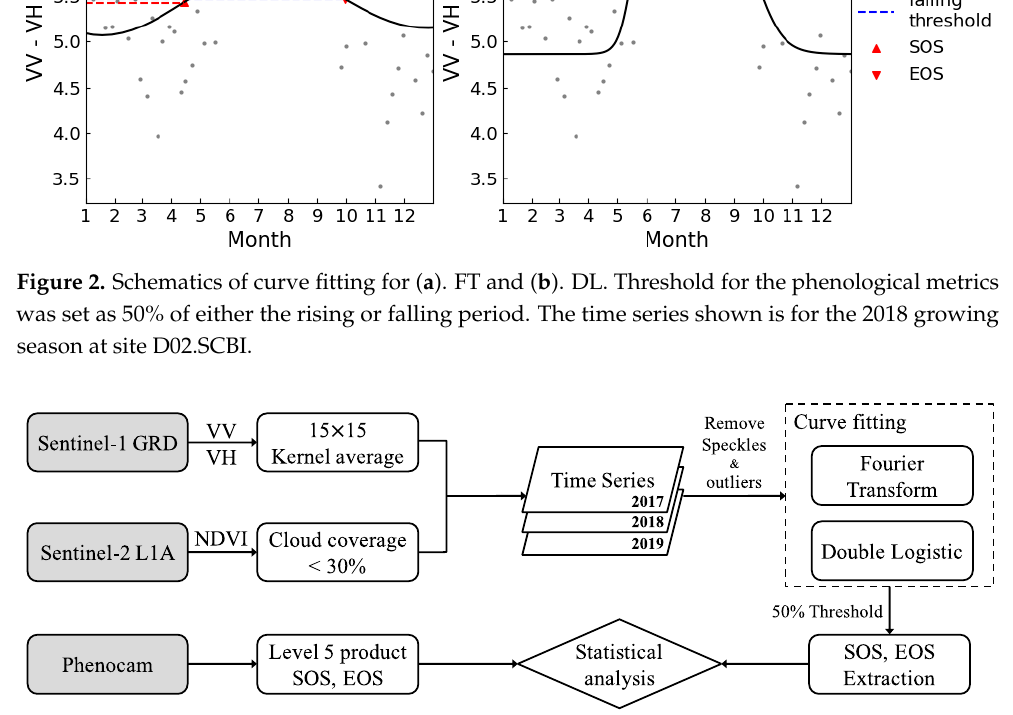
Figure 3. Flowchart for the forest phenology extracting and